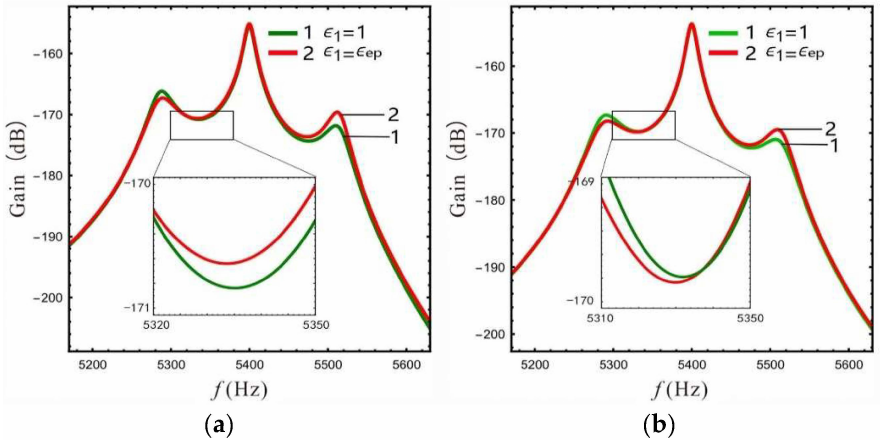
Figure 10. Gain is affected by FCP: ( a ) B = 2.4, ( b ) B =